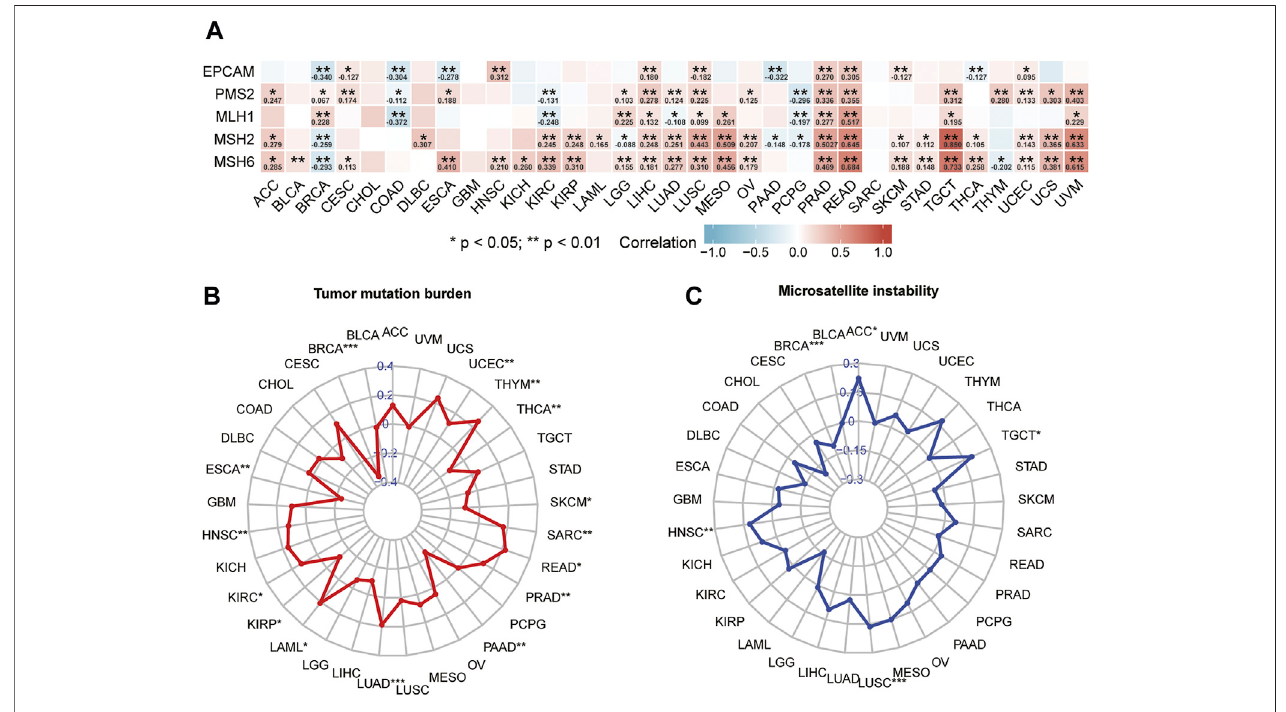
FIGURE 7 | Analysis of correlation between STC2 and mismatch repair genes (A) , tumor mutation burden (B) , and microsatellite instability (C) .